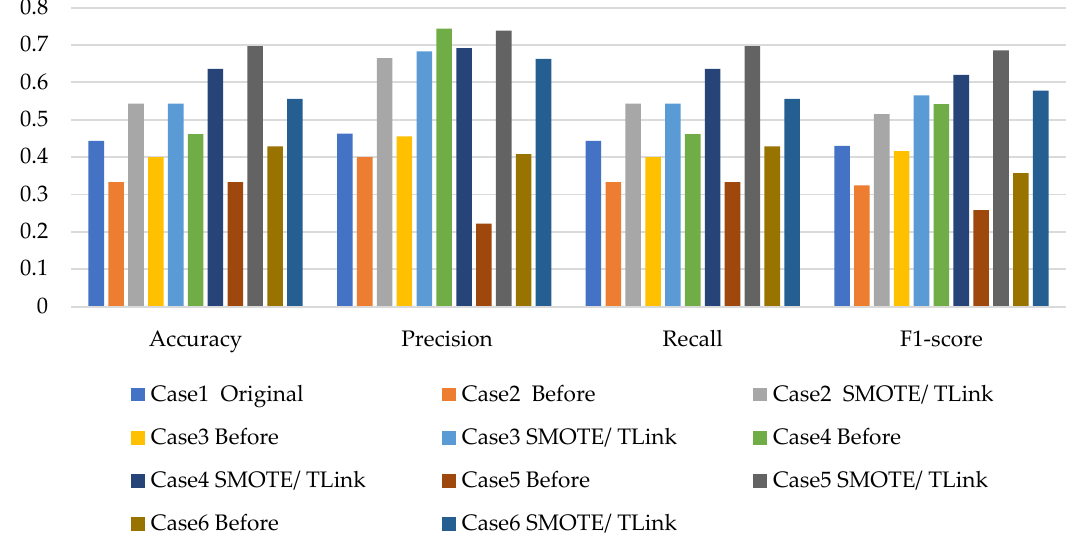
Figure 16. Experimental performance of NBC classification with SMOTE/T-link.